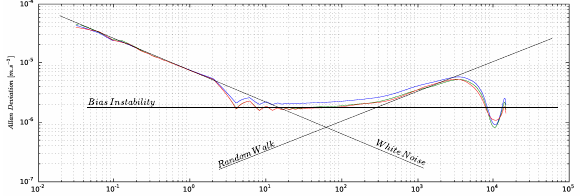
Figure 8: Allan Deviation of three QFLEX-QA-3000-020 ac- celerometers constituting GRAVIMOB. The figure shows clearly the presence of three distinct stochastic processes: white noise, random walk and bias